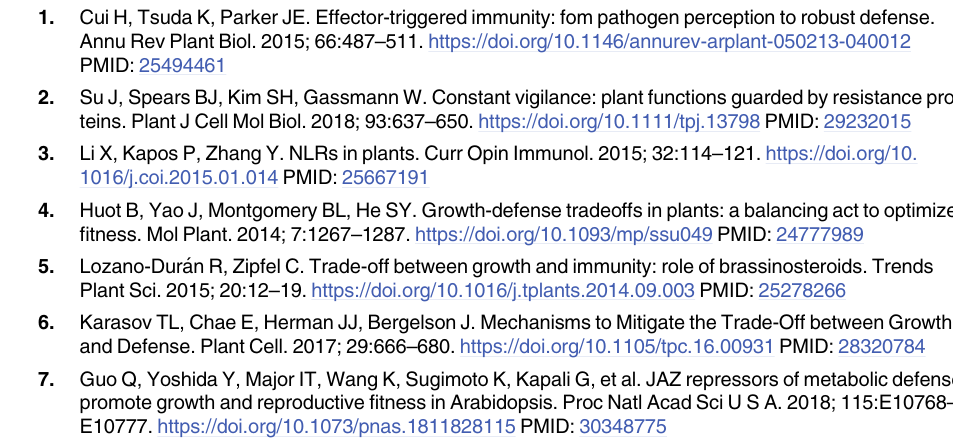
S1 Table. PCR primers used for genotyping mutant lines. S2 Table. Primers used for